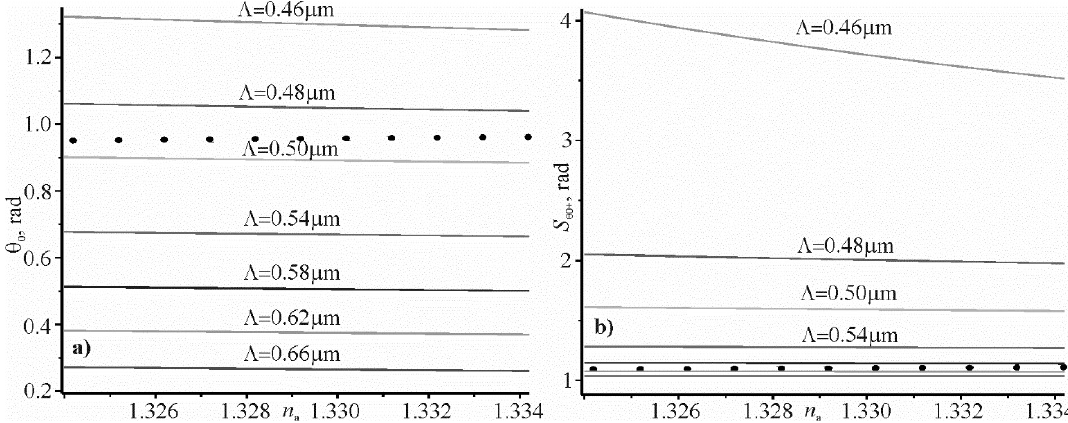
Figure 3. The dependence of the resonance angle at the excitation of the surface plasmon–polariton wave ( a ) and dependence of the sensitivity ( b ) on the refractive index n a of aqueous solution for several grating periods. The black circles reflect the resonance angles and sensitivities of the prism structure. The same color curves correspond to the same grating periods.